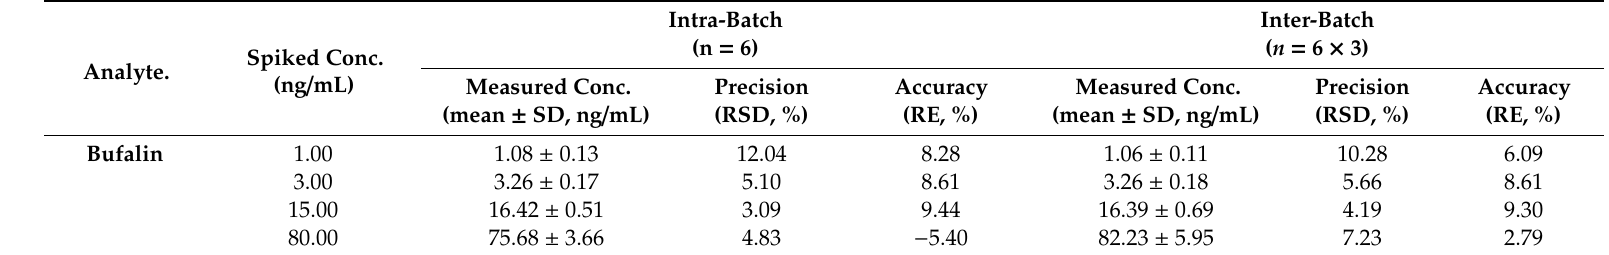
Table 4. Precision and accuracy for bufalin in rat plasma ( n = 6).